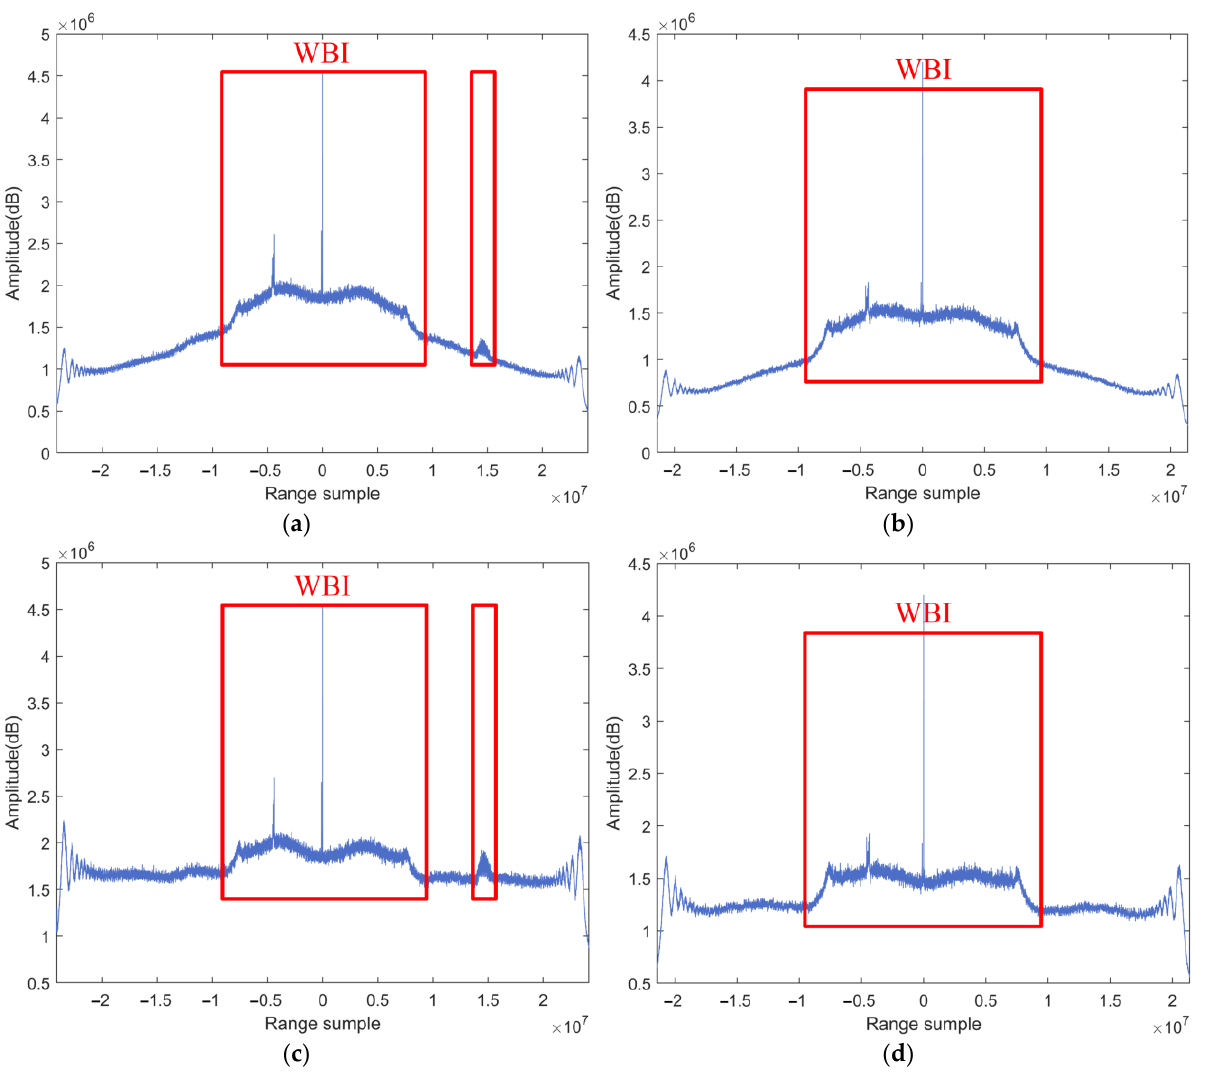
Figure 12. The 1-D range spectrums of the WBI-contaminated SLC data. ( a , b ) Range spectrums of scene 1 and scene 2 before the de-windowing operation, respectively. ( c , d ) Range spectrums of scene 1 and scene 2 after the de-windowing operation, respectively.